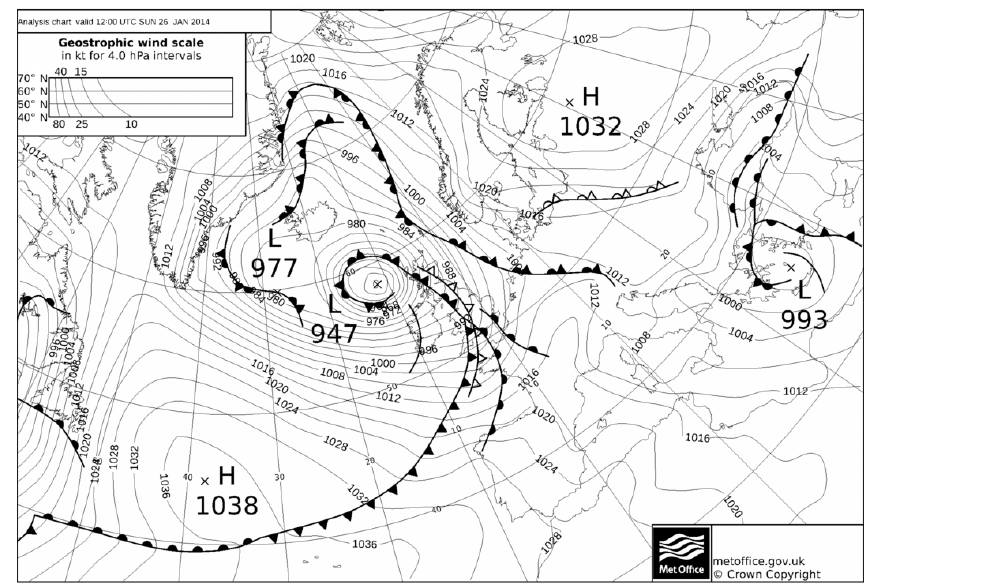
Figure 13. Synoptic chart of the storm on 26 January 2014 at 12:00UTC. The depression tracked to the north-west of Ireland causing record breaking waves and phenomenal sea-states ( H s > 14m). © Crown Copyright (Met Office,